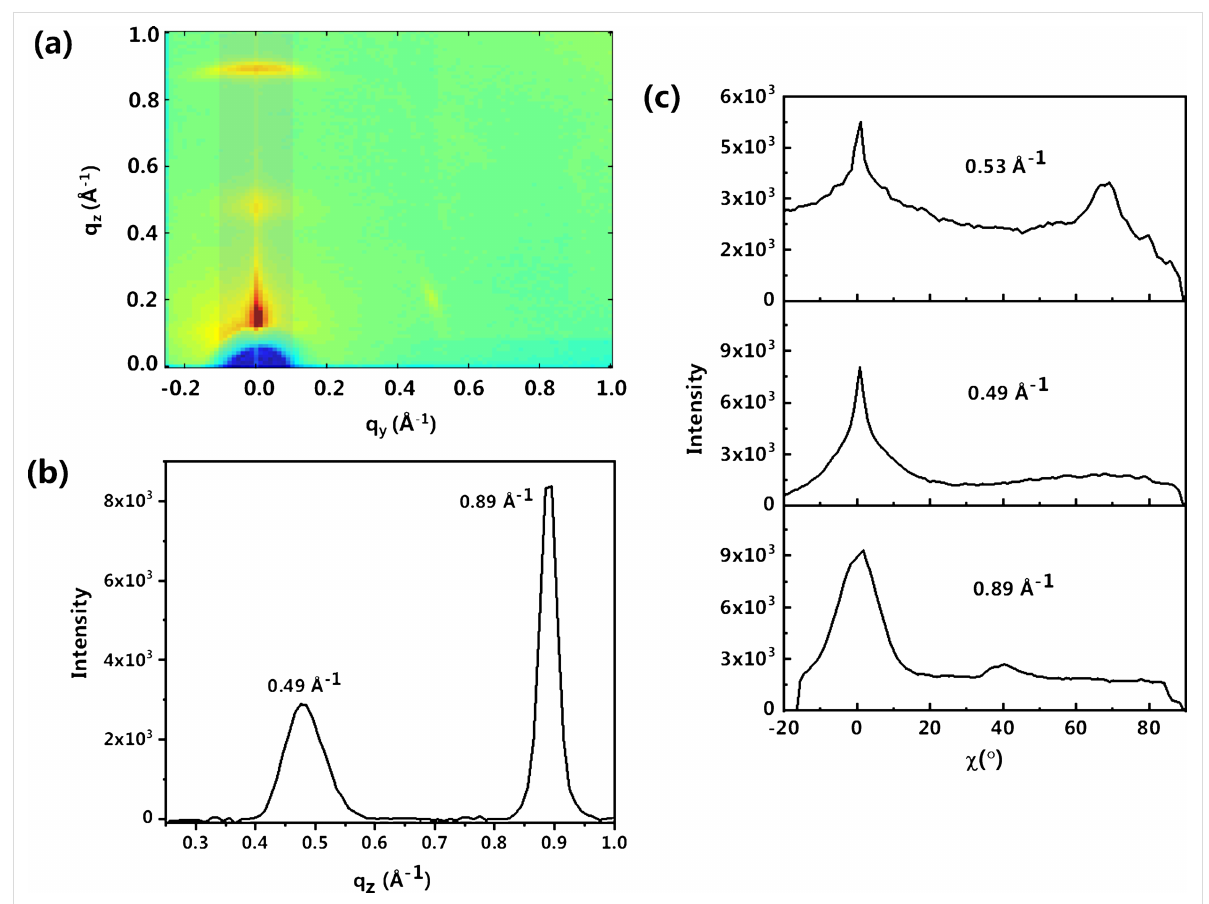
Figure 3: (a) 2D-GIXRD pattern of a 10 nm PbPc film on SLG/SiO 2 /Si. (b) Profile section along the q z direction. (c) Intensity as a function of the azimuthal angle for different Bragg peaks.